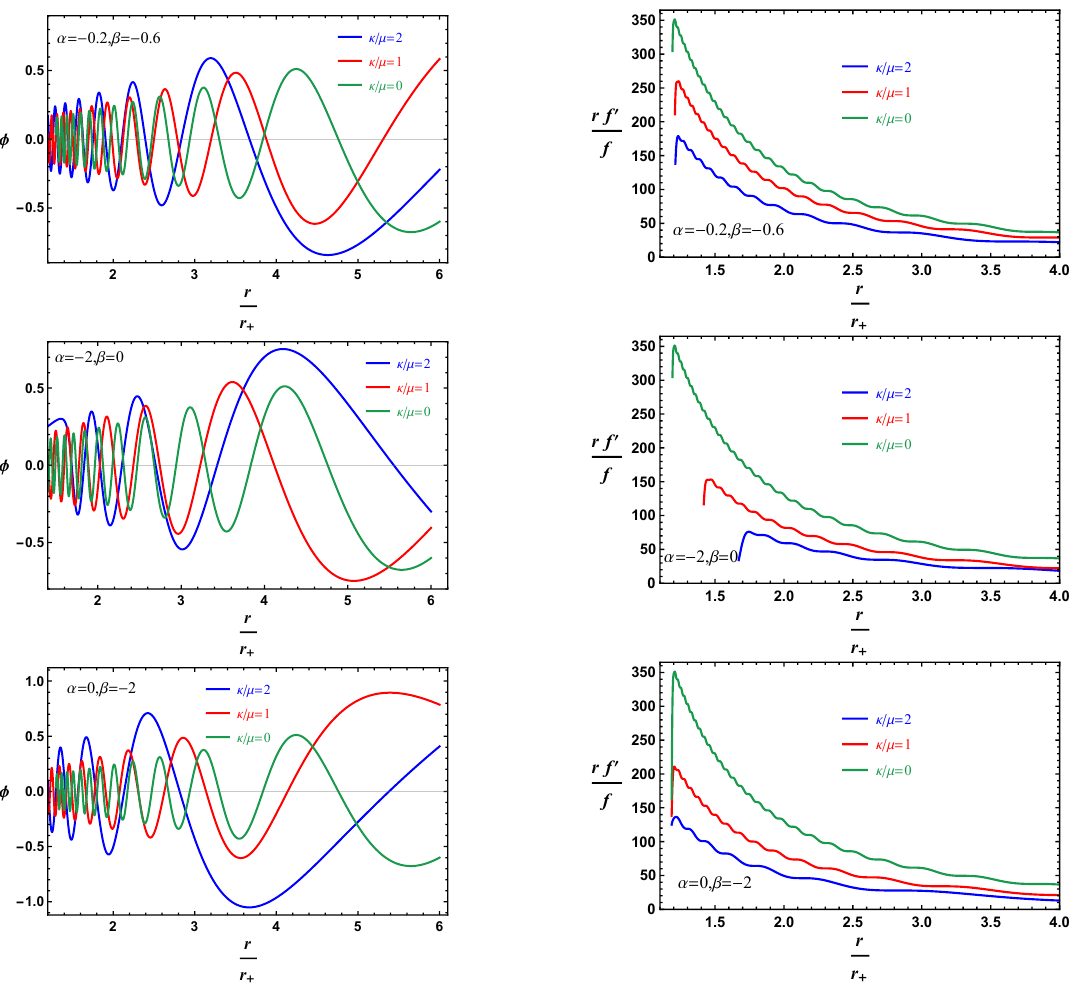
Figure 8 . The dynamical evolution of φ and rf 0 /f as one changes the amount of the massive parameter κ/µ . These graphs are at T/T c = 0 . 995